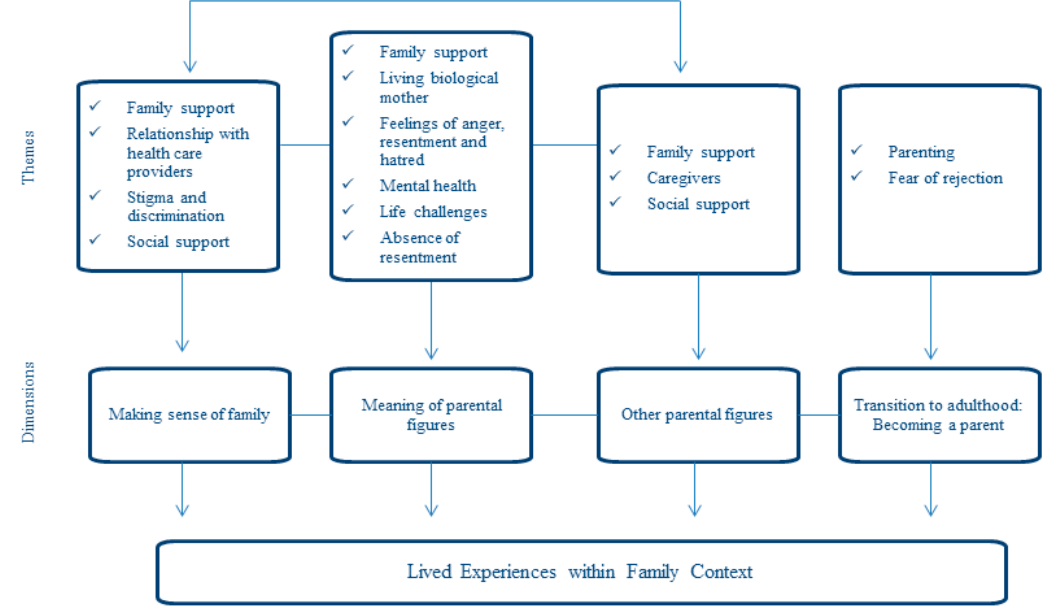
Figure 1. Patterns and connections among themes that emerge during phenomenological analysis.